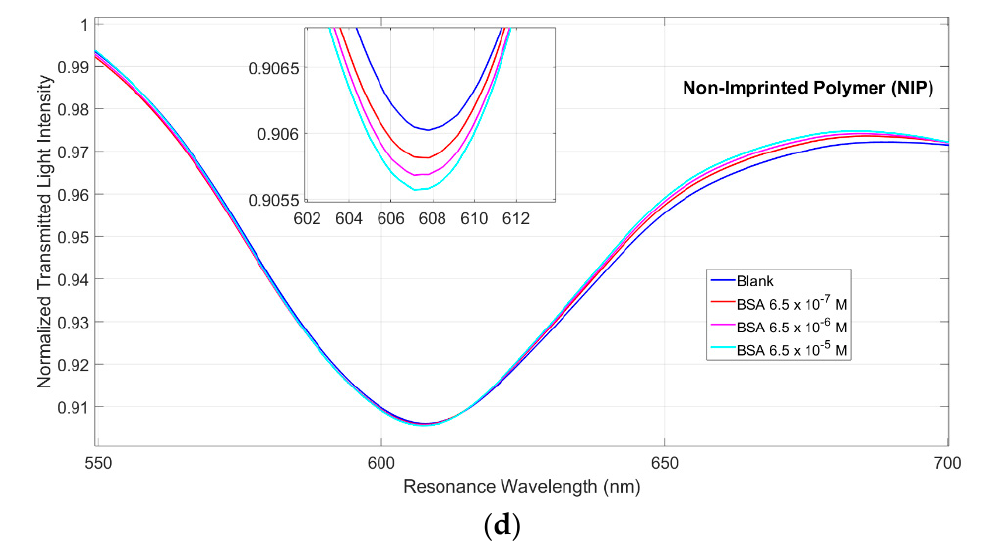
Figure 3. ( a ) Growth profile of MIP layer on SPR transductor registered with SPR Shift response. ( b ) SPR curves of different BSA protein concentrations in phosphate buffer pH 7.4 exploiting SPR-POF sensor combined with a specific MIP for Bovine serum albumin (BSA) protein. ( c ) BSA dose-response curve with Hill fitting of data. ( d ) SPR curves obtained with non-imprinted polymer (NIP) modified SPR-POF sensor at different protein concentrations in phosphate buffer pH 7.4. Table 1. Hill parameters of bovine serum albumin (BSA) detection.